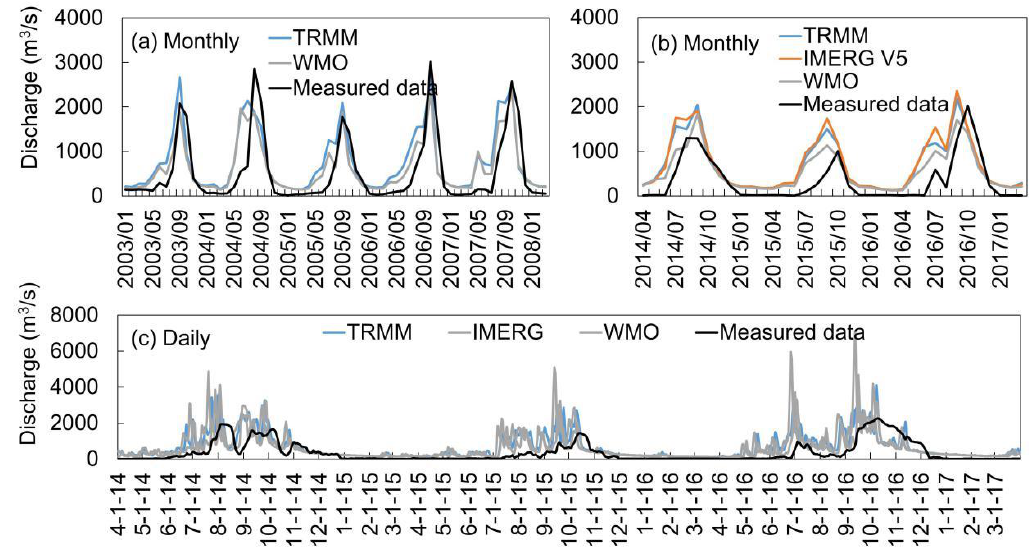
Figure 6. The comparison among simulated and measured runoff: ( a ) Monthly runoff from 2003 to 2008 for calibration; ( b ) monthly runoff from 2014 to 2017 for validation and, ( c ) daily runoff from 2014 to 2017 at M.7 hydrological station of Mun-chi river.